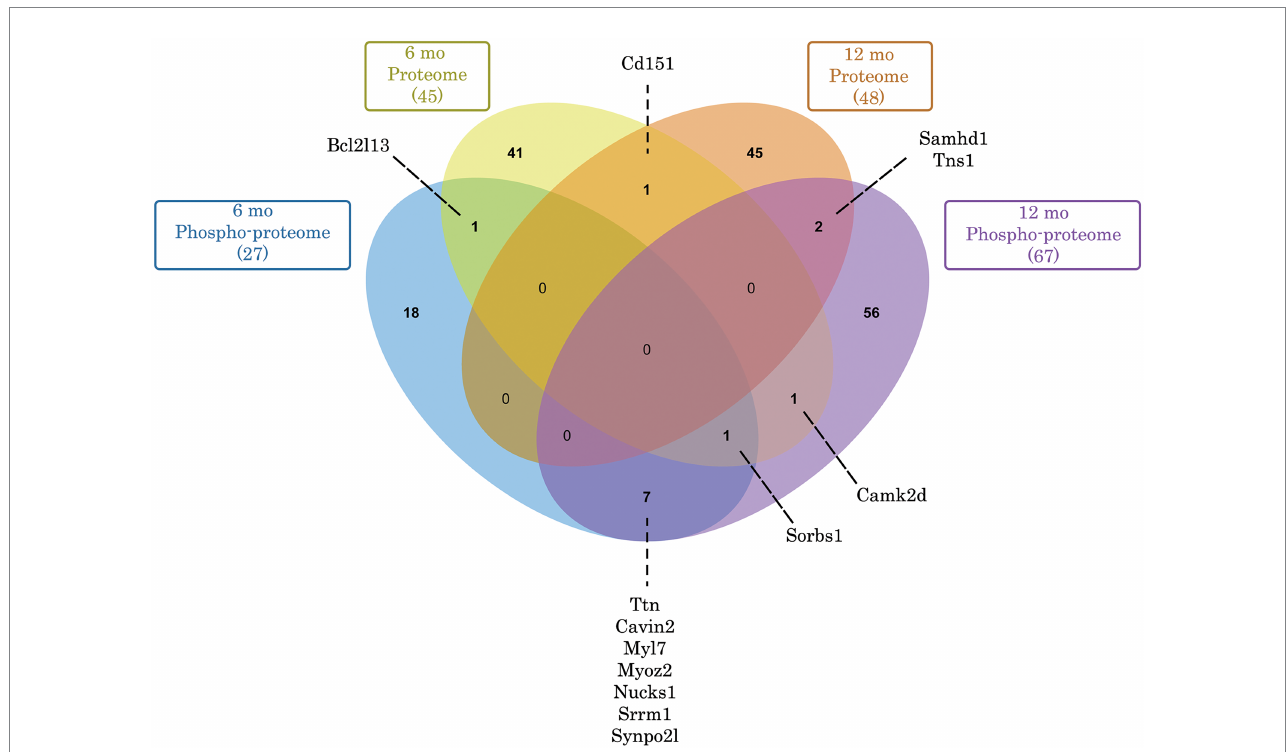
FIGURE 5 Venn diagram depicting commonly deregulated proteins and phospho-proteins in Obscn- Δ Ig58/59 atria through aging. Of the 45 (6-months) and 48 (12-months) proteins that exhibited significantly deregulated expression in Obscn- Δ Ig58/59 atria, only 1 (Cd151) was deregulated at both timepoints. In contrast, of the 27 (6-months) and 67 (12-months) deregulated phospho-proteins in Obscn- Δ Ig58/59 atria, a total of 8 (Ttn, Cavin2, Myl7, Myoz2, Nucks1, Srrm1, Synpo2l, and Sorbs1) were consistently deregulated through aging, albeit at different sites and/or affected in opposite directions at 6- versus 12-months (Supplementary Tables S2, S4). Lastly, CaMKII δ exhibited deregulated expression at 6-months and altered phosphorylation at 12-months in Obscn- Δ Ig58/59 atria. Venn diagram generated with jvenn